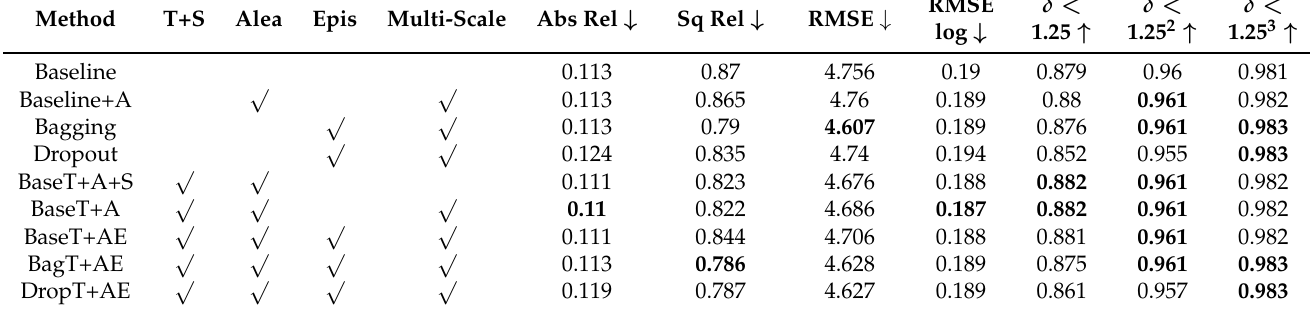
Table 2. Ablation. The results of our different strategies for monocular depth evaluation using Eigen split at KITTI. The best results in each metric are shown in bold.